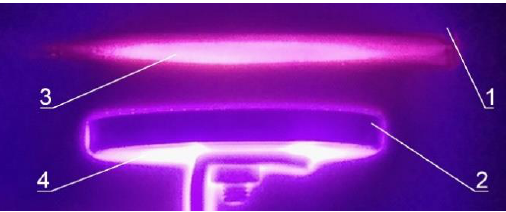
Fig. 2. Burning process of anomalous glow discharge in pulse mode. 1 - anode, 2 - cathode (part), 3 - anode glow, 4 - cathode glow.